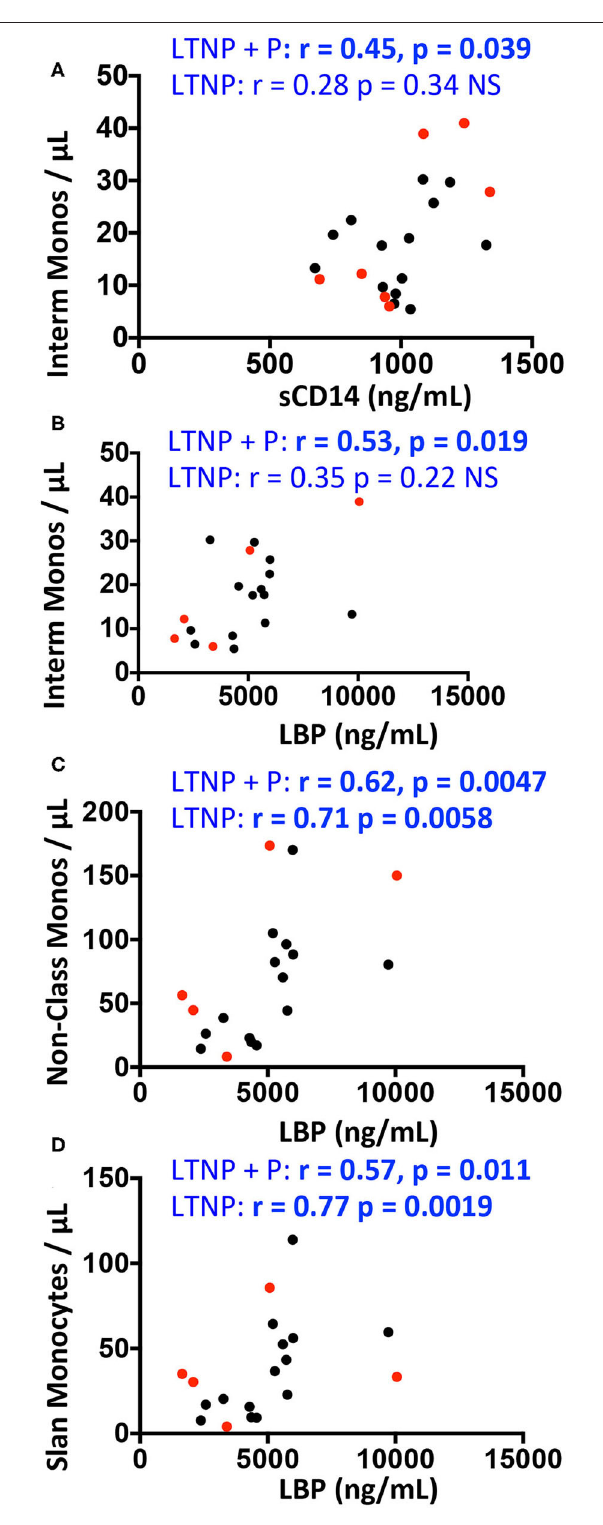
FIGURE 5 | Correlations between monocyte counts and plasma concentrations of sCD14, sCD163, and LBP in HIV-2 infected participants and uninfected controls (GeoHD), all of West-African origin. Data from PLWHIV-2